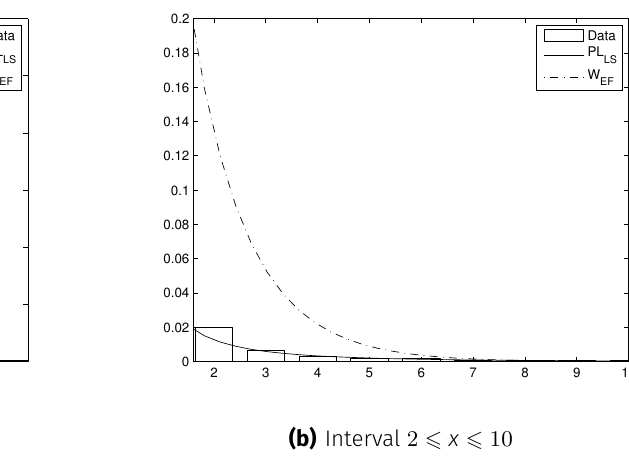
Figure 3. Data and fitted densities on different